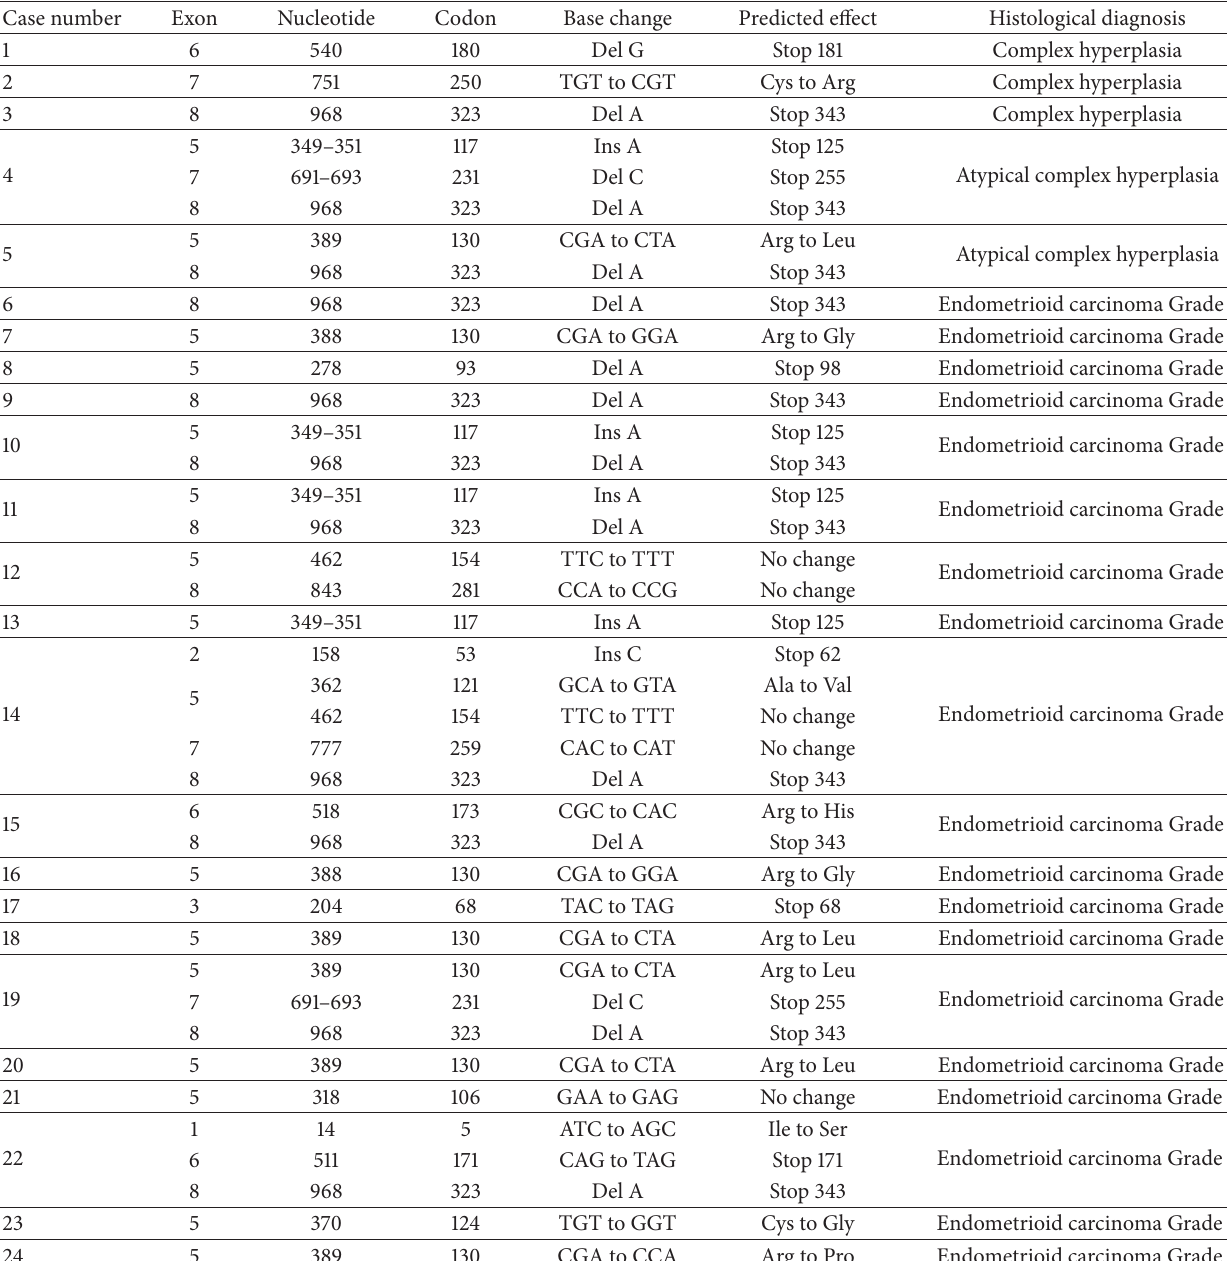
Table 2: List of PTEN mutations in endometrial samples.